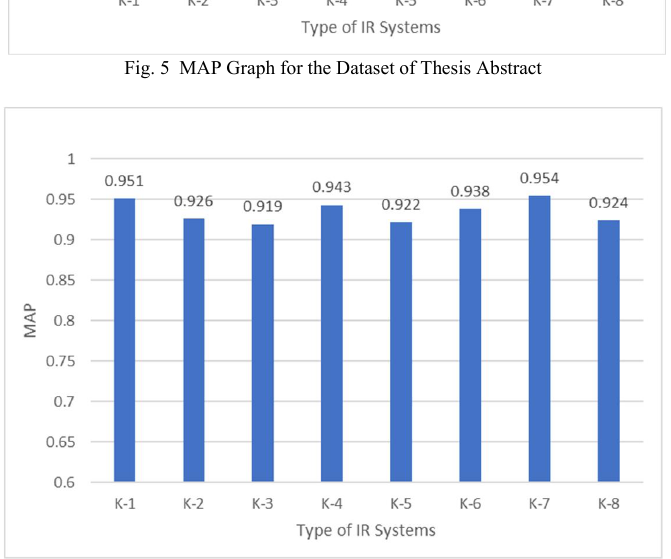
Fig. 6 MAP Graph for the News